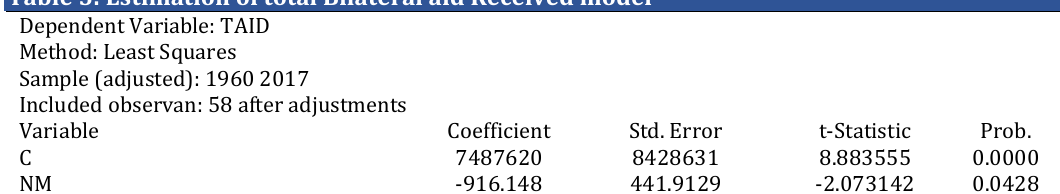
Table 5: Estimation of total Bilateral aid Received model Dependent Variable: